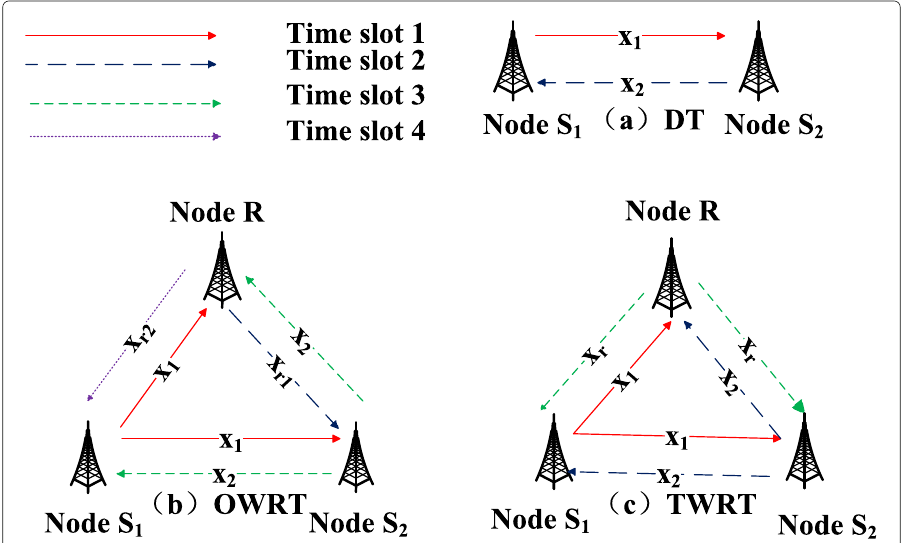
Fig. 1 Transmission models: a DT, b OWRT, and c